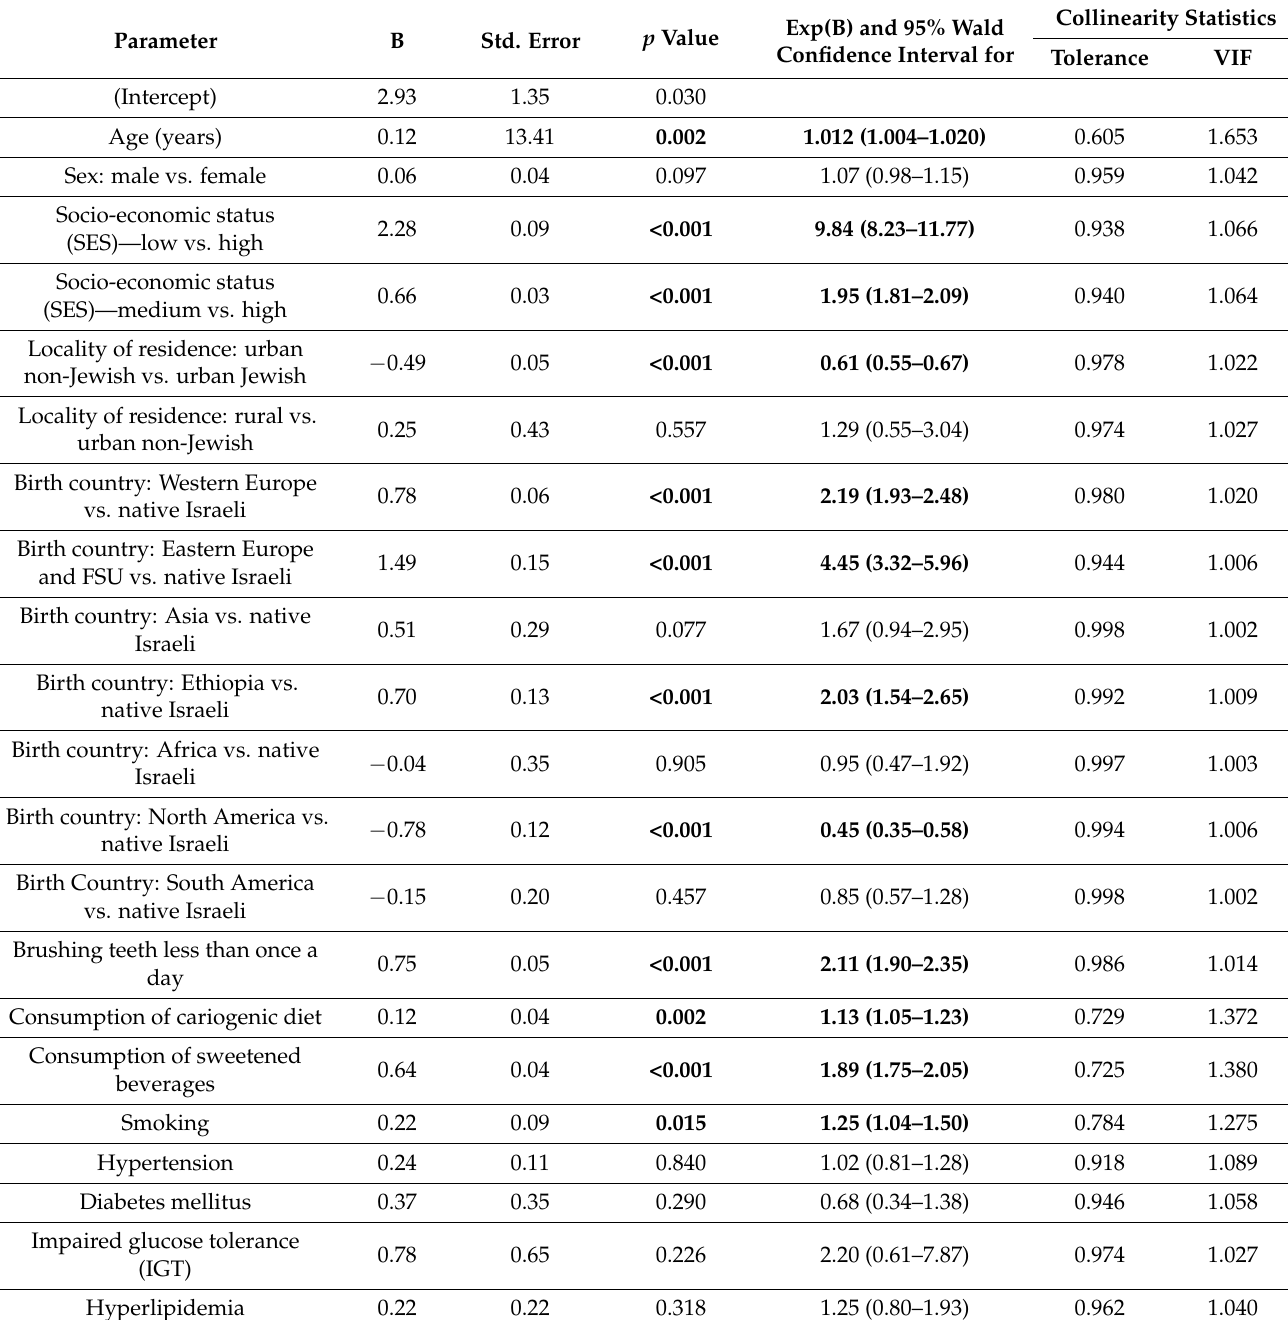
Table 5. Multivariate linear regression analysis for SDU-D (delivered procedures) as the dependent variable with statistically significant independent parameters including collinearity statistics (statistically significant parameters are in bold